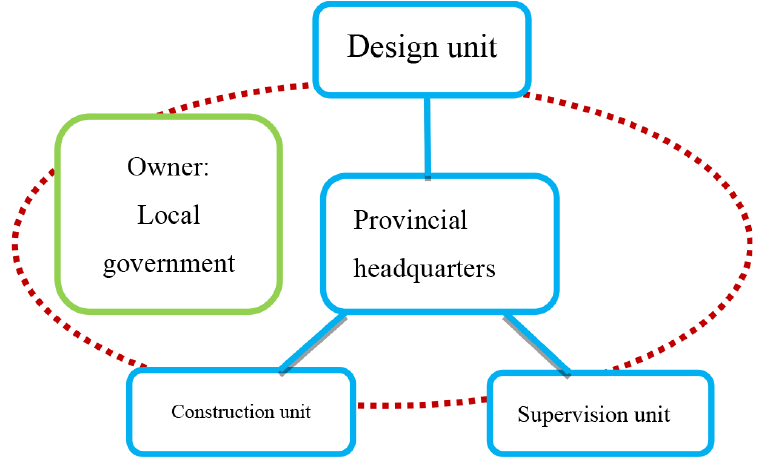
Figure 2. Stakeholders in the